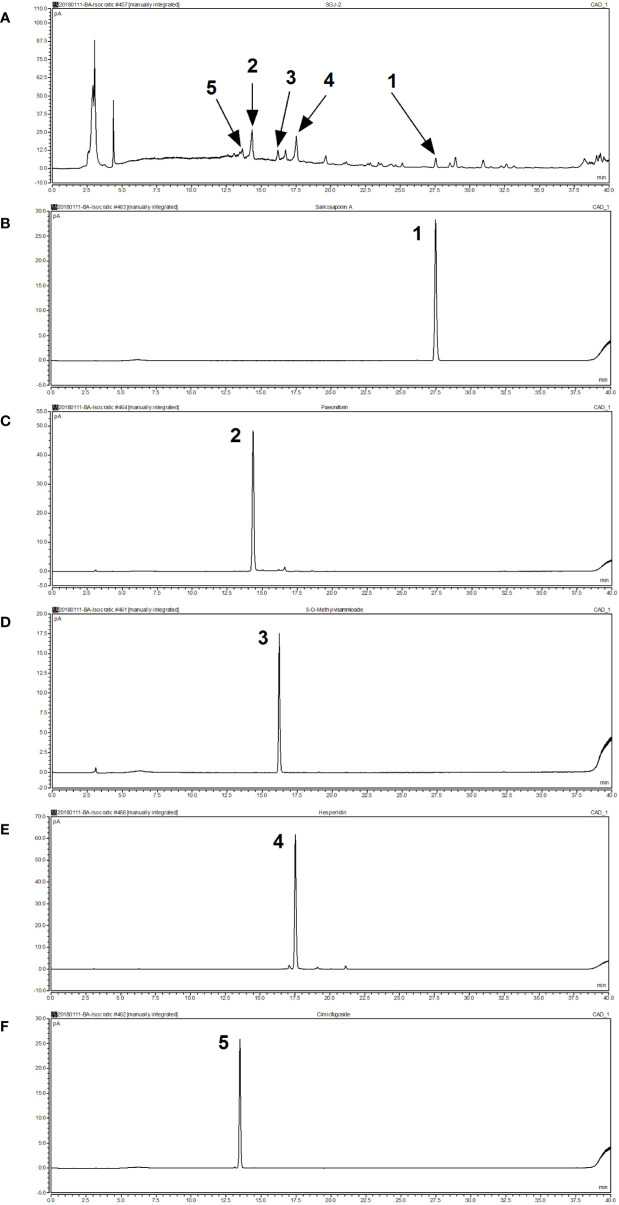
Analysis of the chemical composition of Shugan decoction (SGD) extract by HPLC. (A) HPLC chromatogram of SGD extract (B) HPLC chromatogram of saikosaponin A (C) HPLC chromatogram of paeoniflorin (D) HPLC chromatogram of 5-O-methylvisammioside (E) HPLC chromatogram of hesperidin (F) HPLC chromatogram of cimicifugoside. Peak 1: saikosaponin A; Peak 2: paeoniflorin; Peak 3: 5-O-methylvisammioside; Peak 4: hesperidin; Peak 5: cimicifugoside.